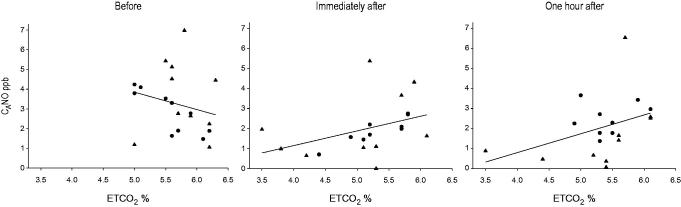
ETCO2 and alveolar nitric oxide (CANO) before, immediately after, and 1 hour after the race, in runners (•) and marathoners (▴). Before the race the correlation was: r = –0.30, p = 0.199; immediately after: r = 0.56, p = 0.013; and 1 hour after: r = 0.45, p = 0.052 for all runners.